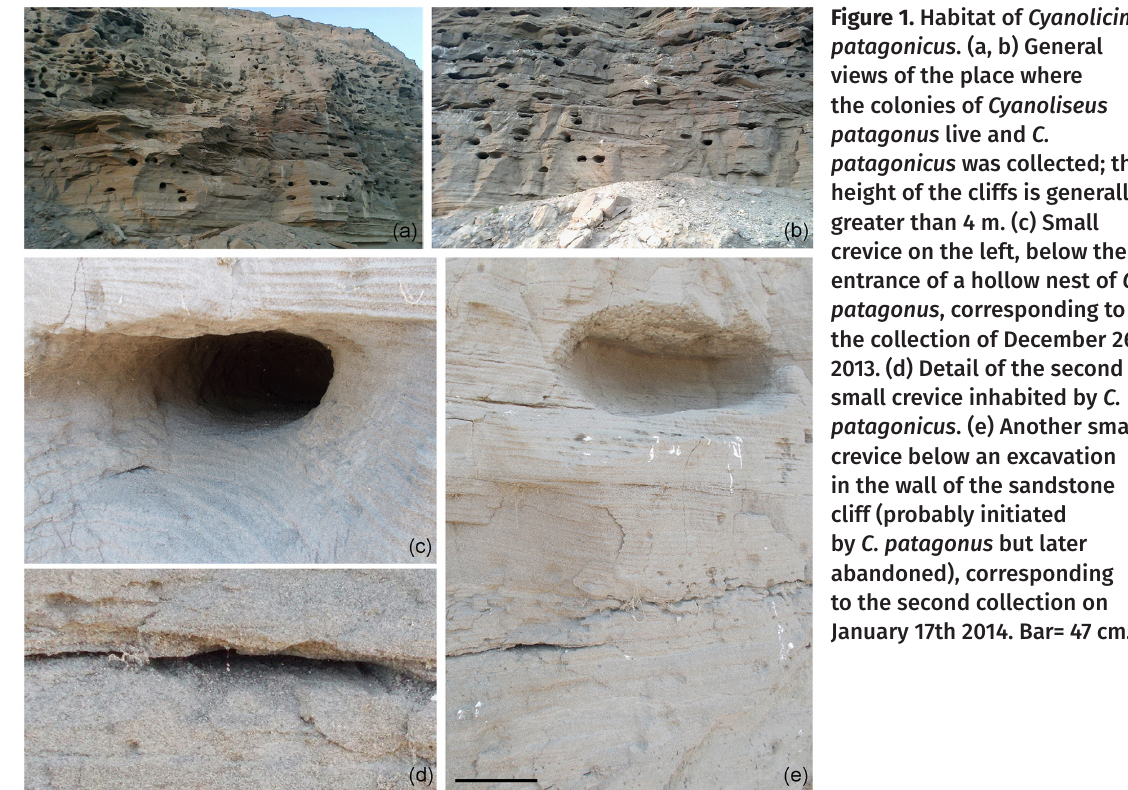
Figure 1. Habitat of Cyanolicimex patagonicus . (a, b) General views of the place where the colonies of Cyanoliseus patagonus live and